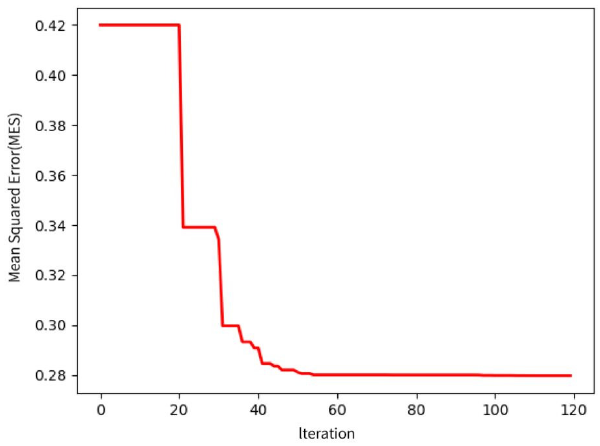
Figure 2. Training error of SFLA.